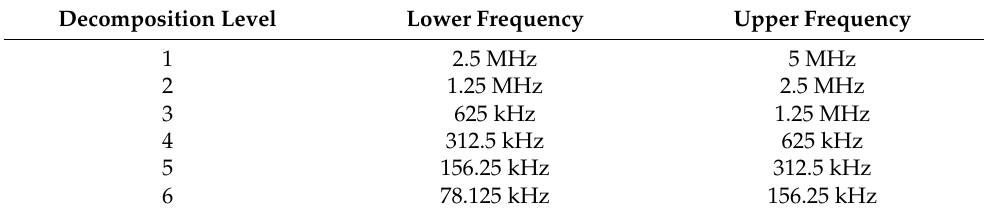
Table 1. SWT Boundaries for frequency